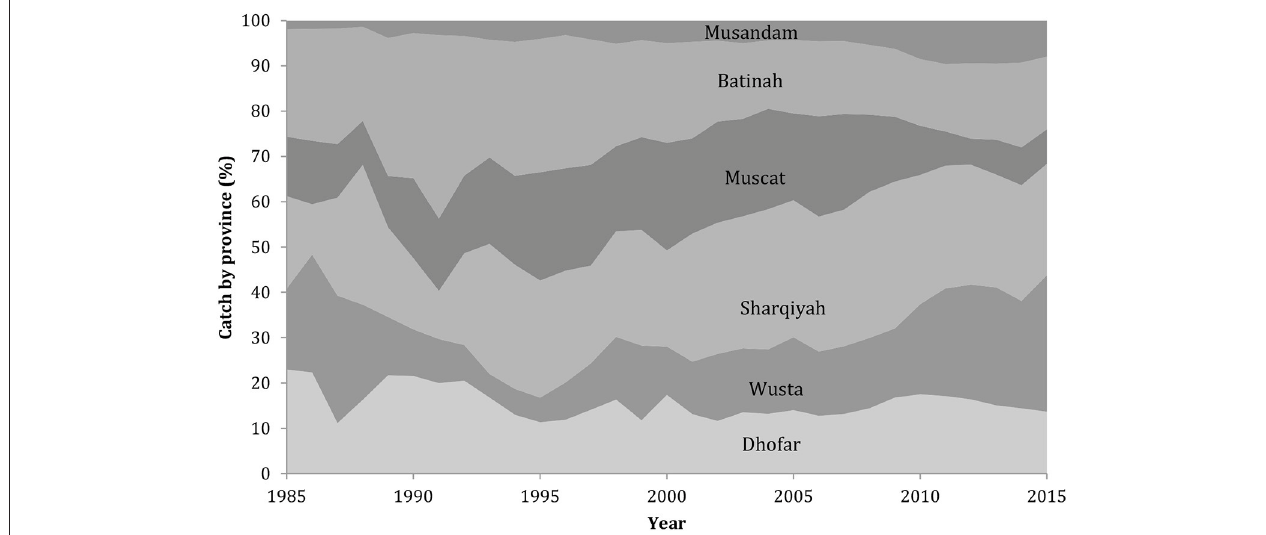
FIGURE 5 | The percentage of marine fisheries catch by Omani province, between 1985 and 2015; presented in this graph according to their geographic position, from Dhofar in the South to Musandam in the North.